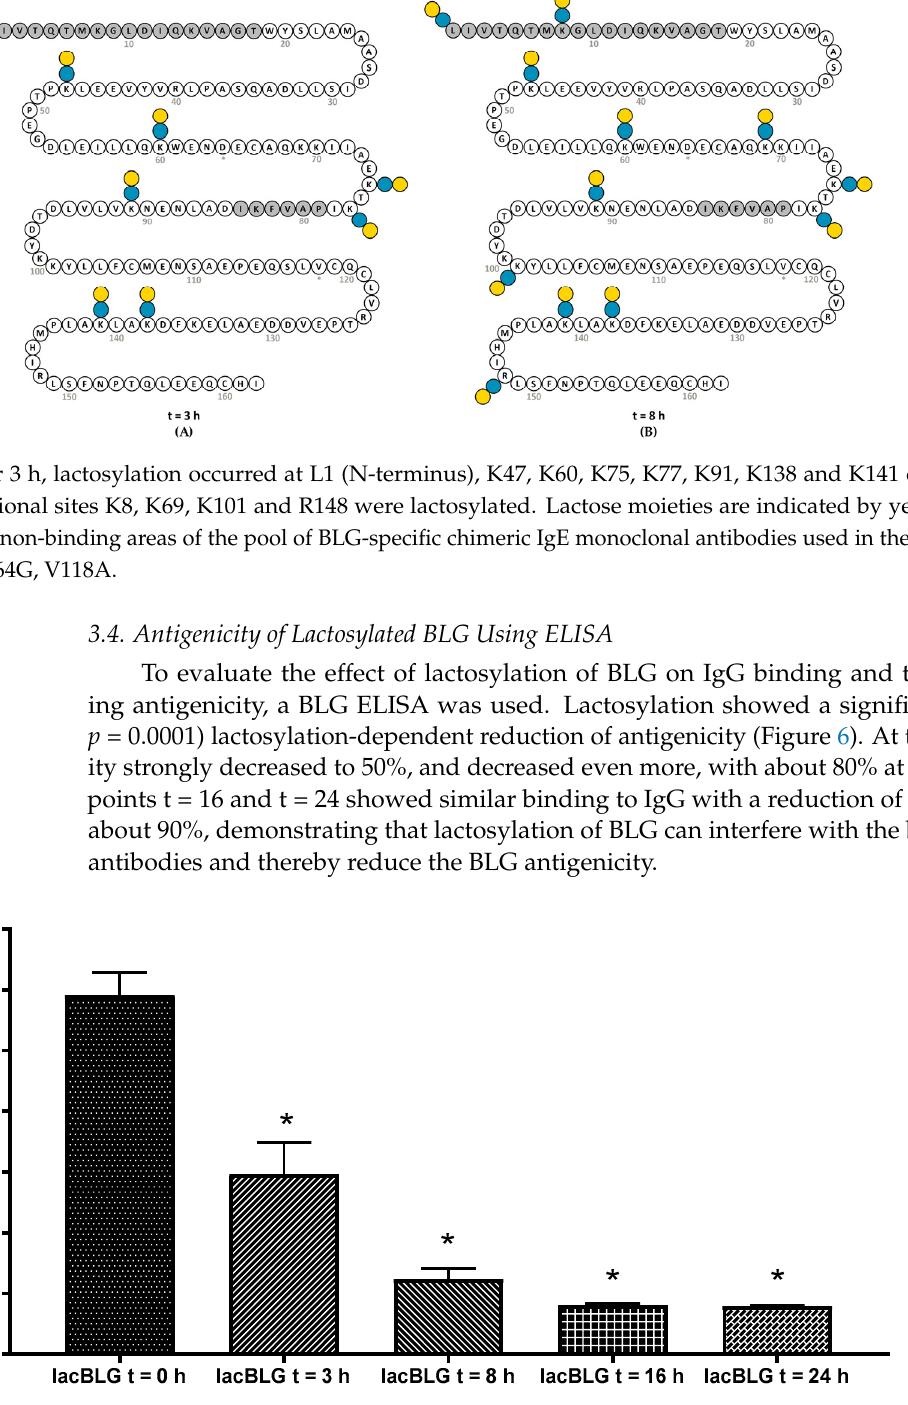
Figure 6. IgG binding (antigenicity) of lactosylated BLGWT (lacBLG) in duplicate using a BLG ELISA. Data are expressed as mean + SD.* One-way ANOVA p = <0.0001.